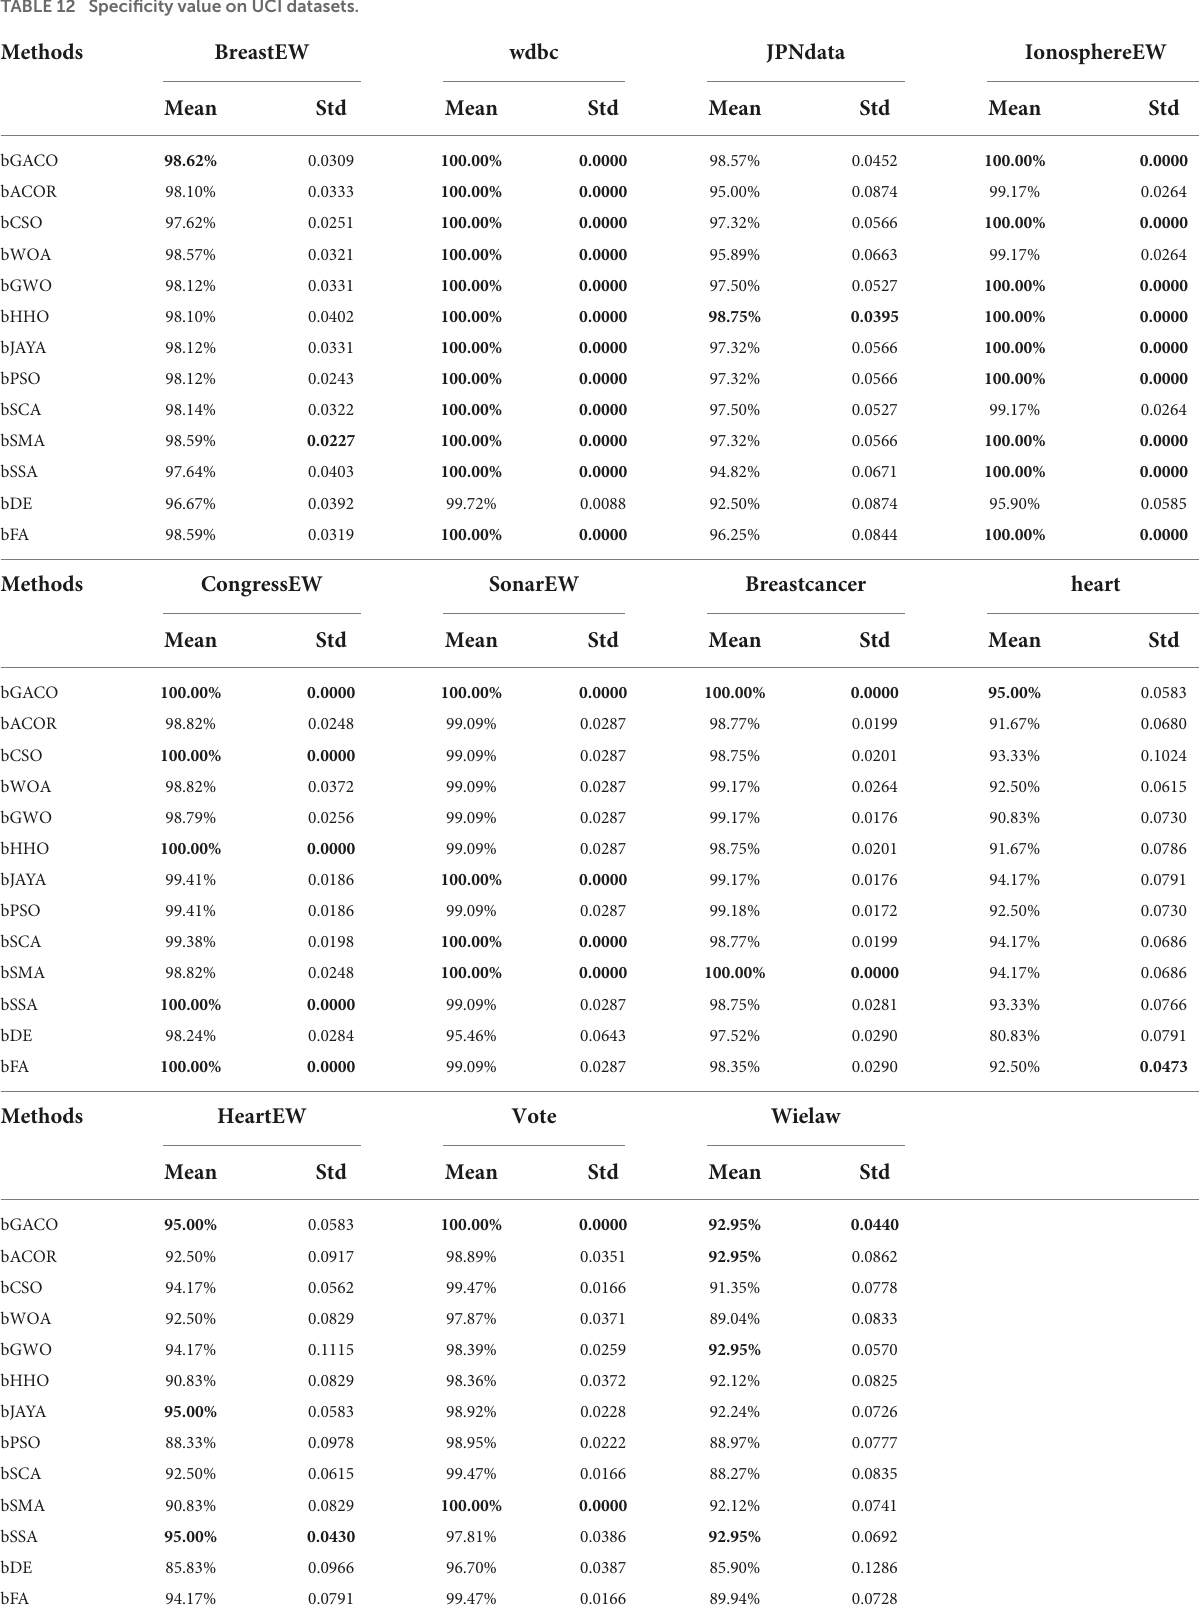
TABLE 12 Specificity value on UCI